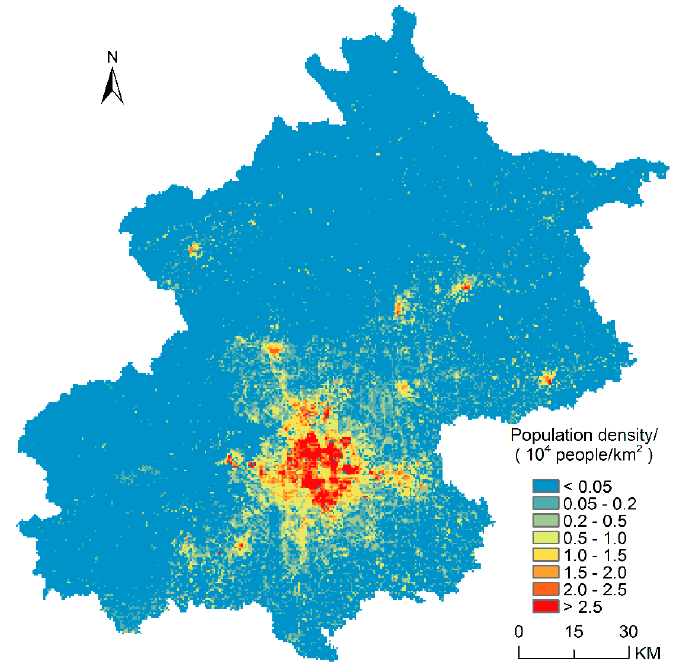
Figure 10. Remotely-sensed population density map of